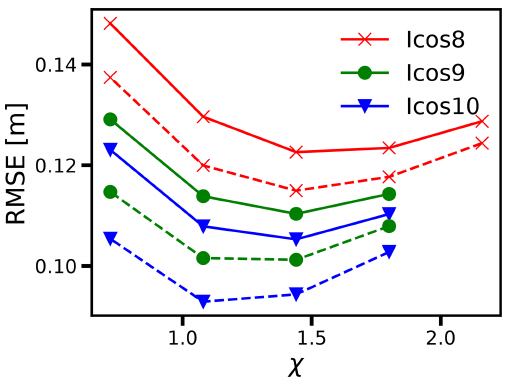
Figure 3. Tuning of the topographic wave drag coefficient χ for runs Icos8 n (solid red with crosses) and Icos8 is (dashed red with crosses), Icos9 n (solid green with circles) and Icos9 is (dashed green with circles), and Icos10 n (solid blue with triangles) and Icos10 is (dashed blue with triangles). See Table 1 for